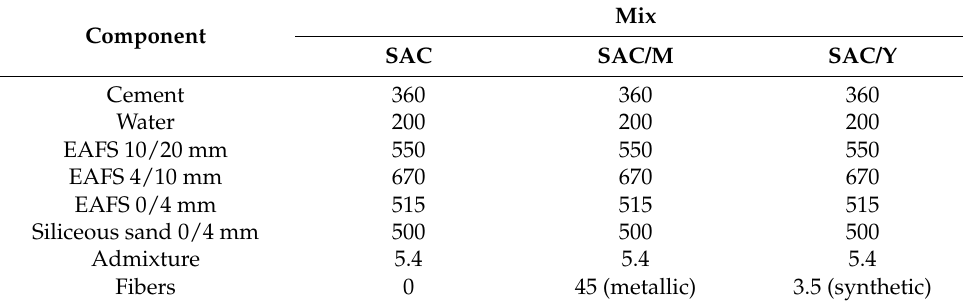
Table 3. Composition of the mixes (kg/m 3 ).